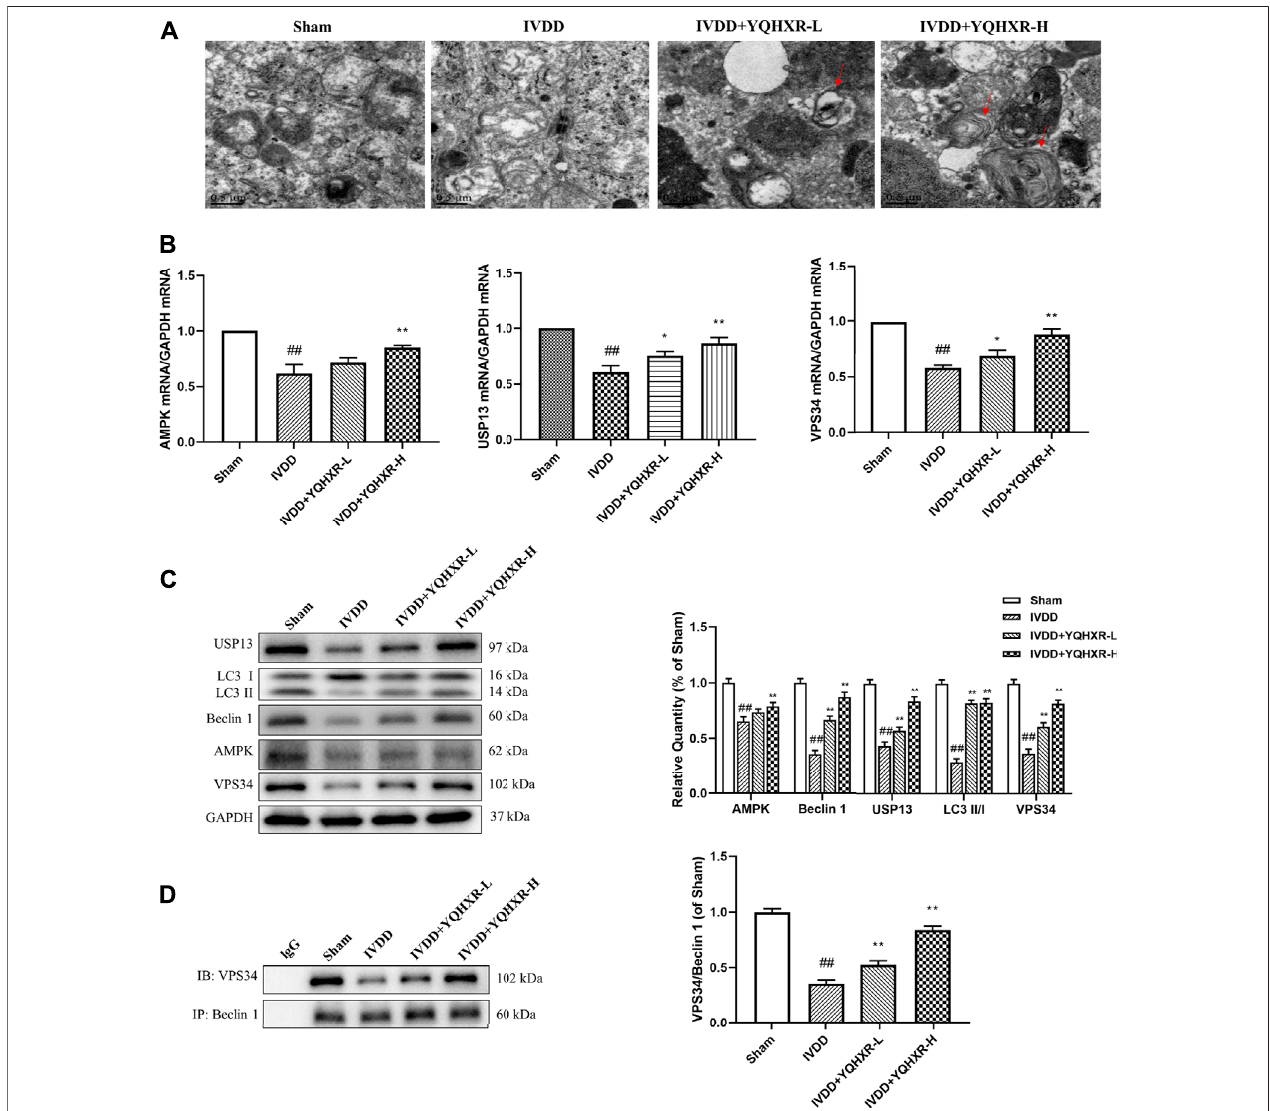
FIGURE 3 | Autophagy was activated by YQBXR administration in needle-punctured IVDD rats. (A) Transmission electron microscope analysis of rat discs (red arrows: autophagosomes or autolysosomes, scale bar: 0.5 μ m). (B) The mRNA levels of autophagy pathway-related gene by real-time PCR analysis. (C – D) Representativebandsofautophagypathway-relatedproteinsbywesternblottingandimmunoprecipitationanalysis,andtheirquantitativeresults.Thedatarepresentthe mean ± SD. Signi fi cant differences are shown as ## p < 0.01 vs Sham group; * p < 0.05, ** p < 0.01 vs IVDD group.